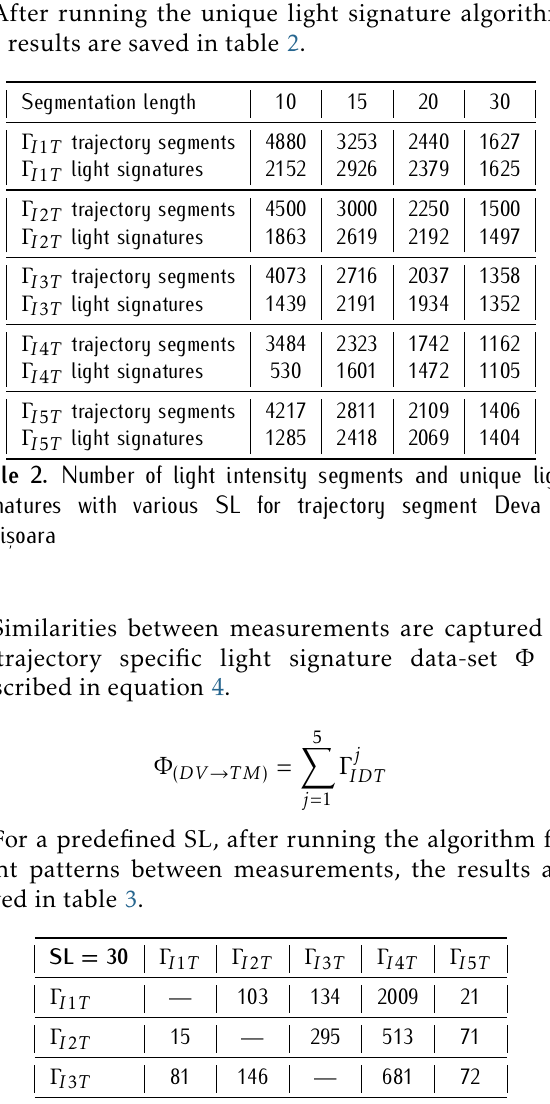
probability distribution based on Γ k